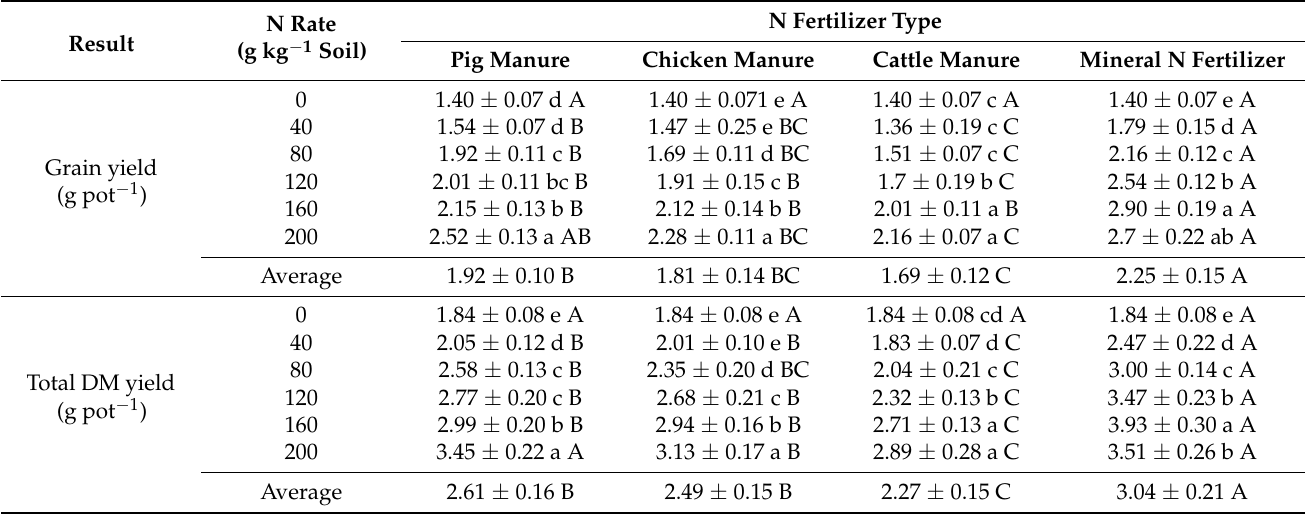
Table 3. Effects of different N fertilizers on N uptake by maize.